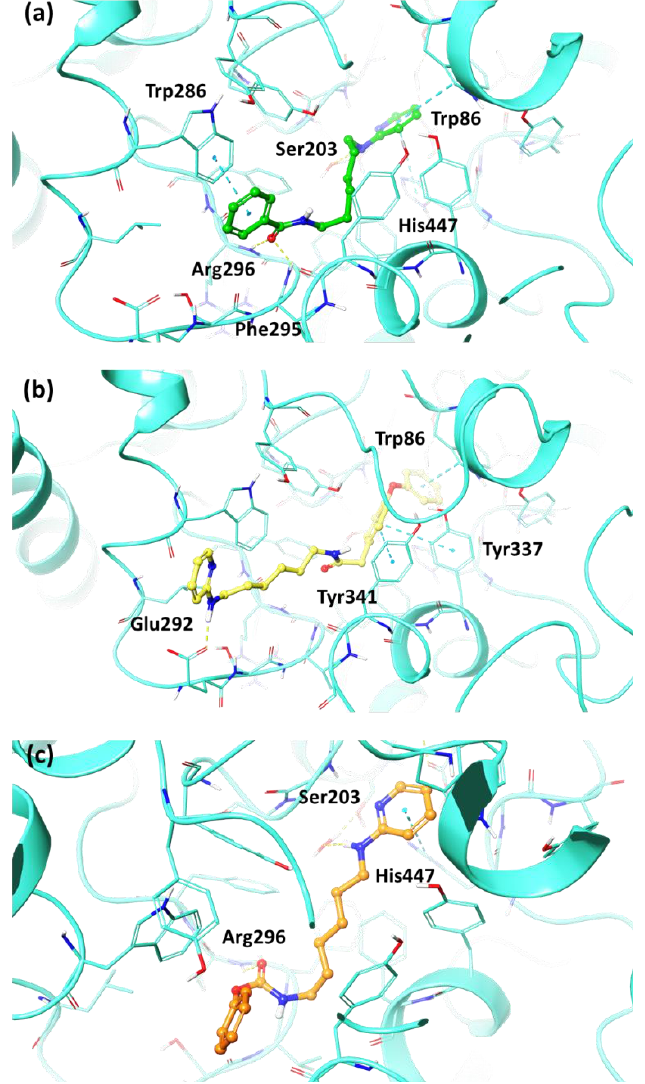
Figure 4. Best docking pose of compounds ( a ) 12 , ( b ) 14 , and ( c ) 18 into the h AChE active site shown as wire representation. Most relevant interacting residues are displayed as thin turquoise tubes. Compounds 12 , 14 and 18 are illustrated in green, yellow and orange carbon ball and stick representations, respectively. Hydrogen bonds and π–π interactions are, respectively, represented in yellow and blue dotted lines.